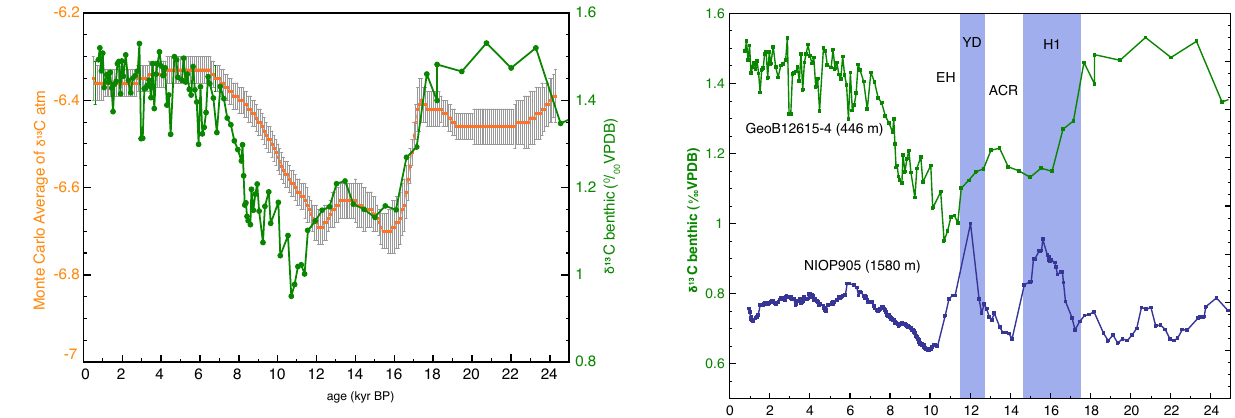
Fig. 7. Comparison of benthic carbon isotope records. GeoB12615- 4 (green) and NIOP905 (purple). For core position see Fig.